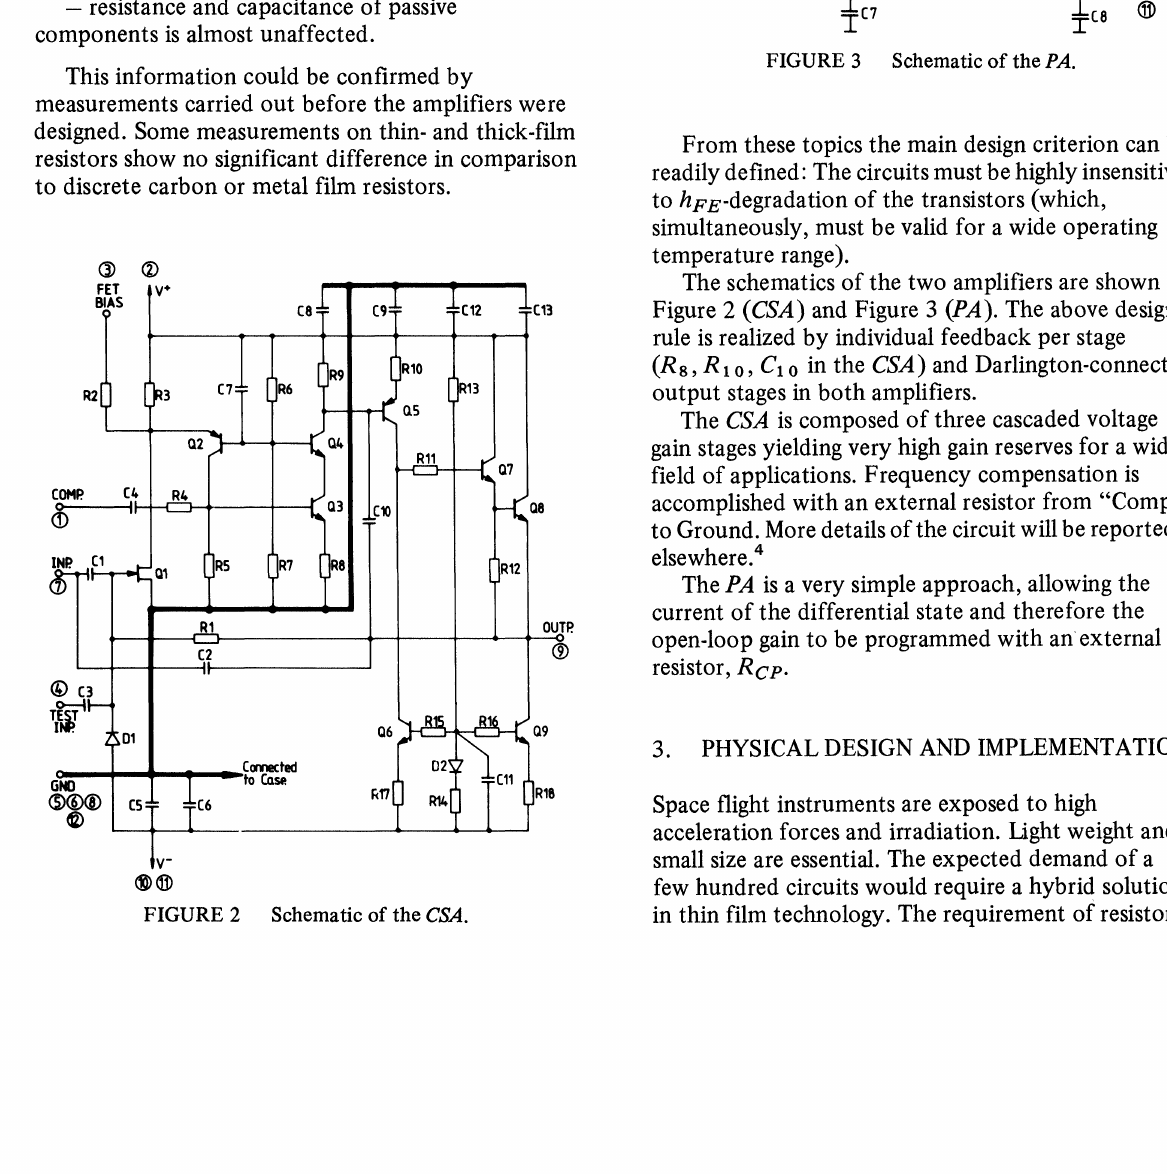
FIGURE 2 Schematic of the CSA.